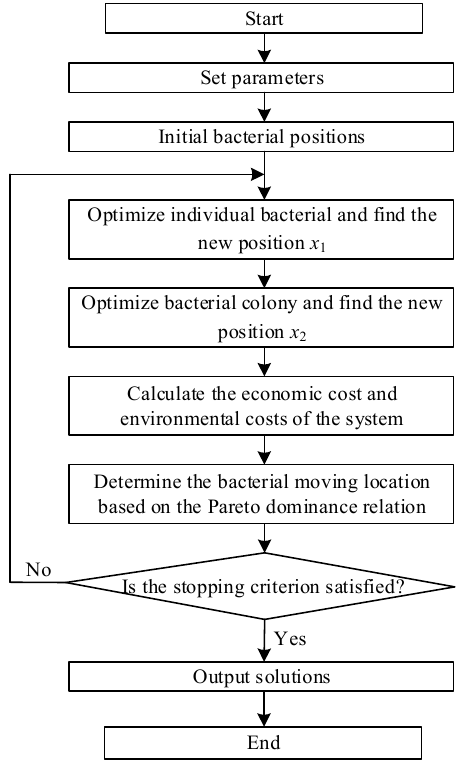
Figure 3. Flowchart of solving process.